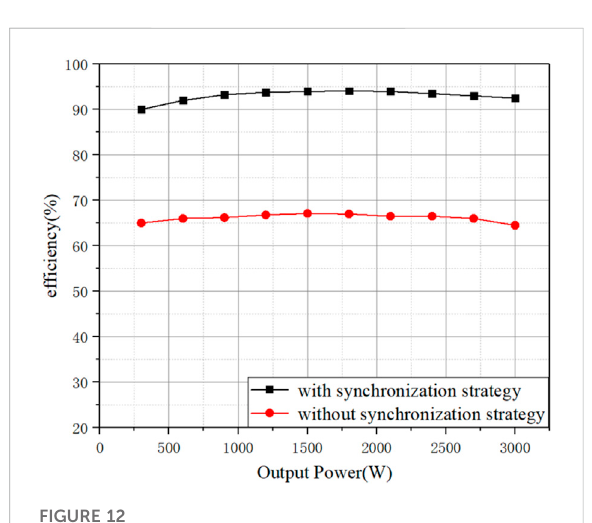
FIGURE 12 The system ef fi ciency at different output